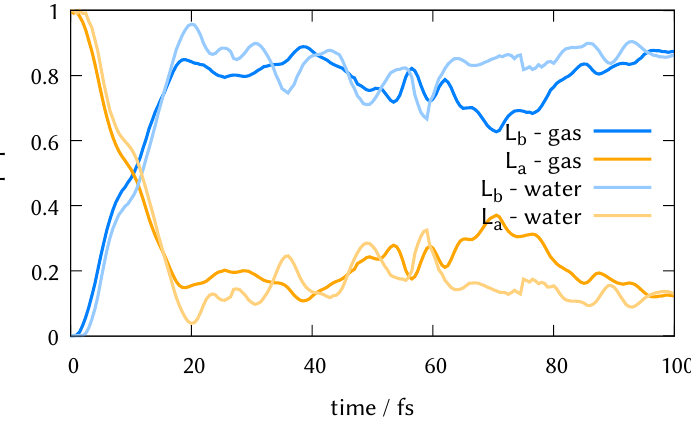
Figure 4. DD-vMCG diabatic electronic populations using 8 nuclear Gaussians starting in the L a state for the molecule in the gas phase and for the microcluster formed by DMABN and two water